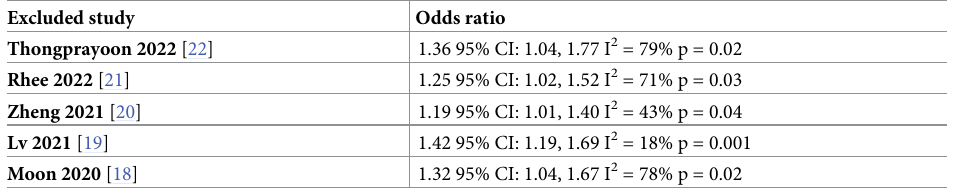
Table 4. Results of sensitivity analysis.